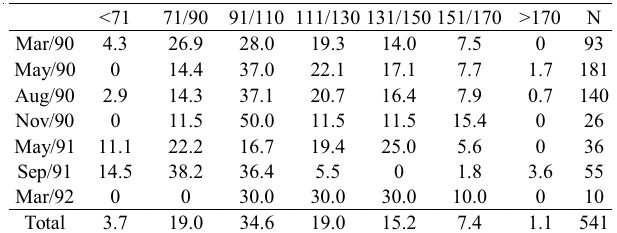
Table 2 . Temporal variation of the length frequency distribu- tion of Bay whiff in the Mamanguá Inlet. N = number of speci- mens.